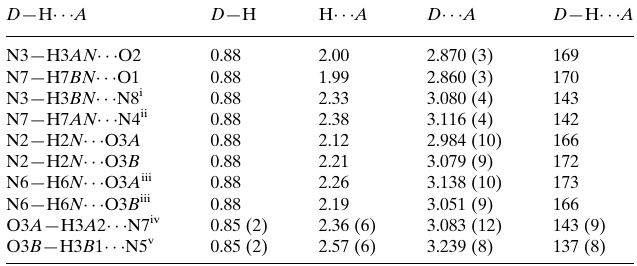
Hydrogen-bond geometry (A˚ , (cid:3)